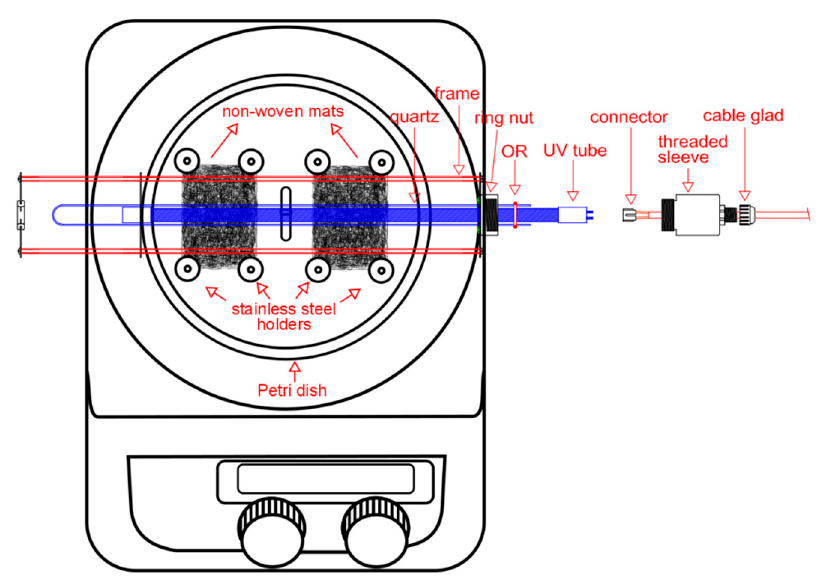
Figure 2. Experimental set-up for testing catalytic activity in formaldehyde degradation.